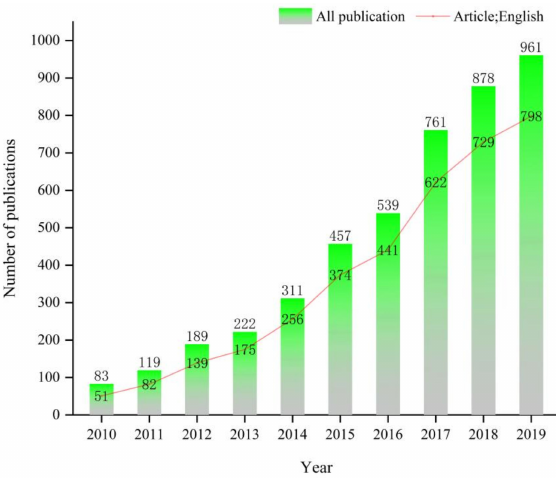
Figure 1. Annual number of publications from 2010 to